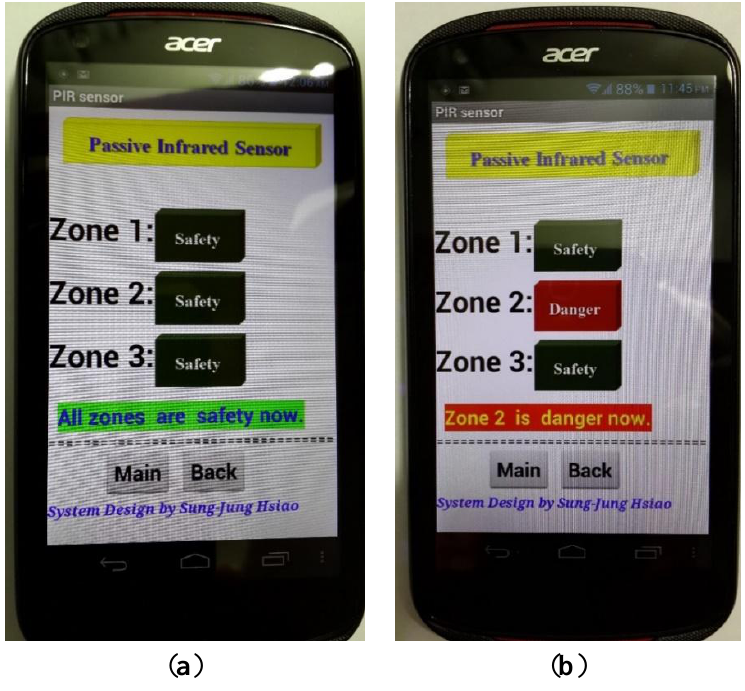
Figure 22. PIR different situation shows on the smartphone. ( a ) Safety situation; ( b ) Showing “Zone 2 is danger now”.